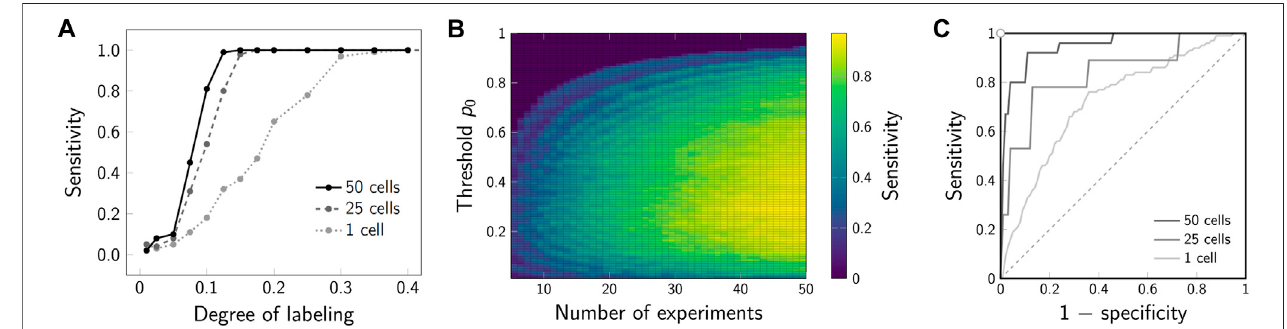
FIGURE 8 | Sensitivity for joint analysis of multiple experiments. (A) Sensitivity for varying degree of labeling. Dimers were simulated and analyzed with 2-CLASTA. The sensitivity for analysis of a single experiment is shown by the dotted line. The sensitivity in case of joint analysis of 25 and 50 cells is shown by the dashed and solid lines, respectively; a threshold of p 0 = 0.05 was chosen. (B) In fl uence of the threshold p 0 and the number of experiments on the sensitivity. The obtained sensitivity is indicated by color. (C) ROC plot for joint analysis of multiple experiments. For the simulations in panels B and D, the degree of labeling was set to 10 % . Sensitivity was calculated from 100 simulation runs; the level of signi fi cance was set to α * =